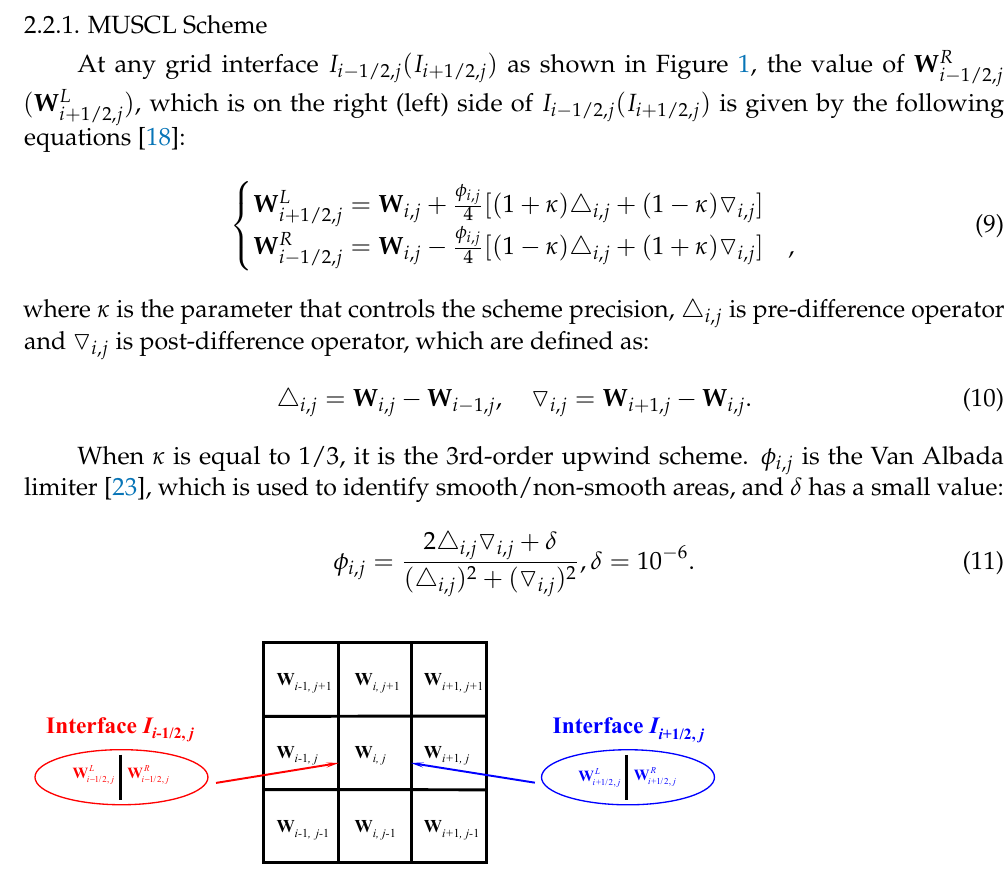
Figure 1. Diagram of 2D structural grid